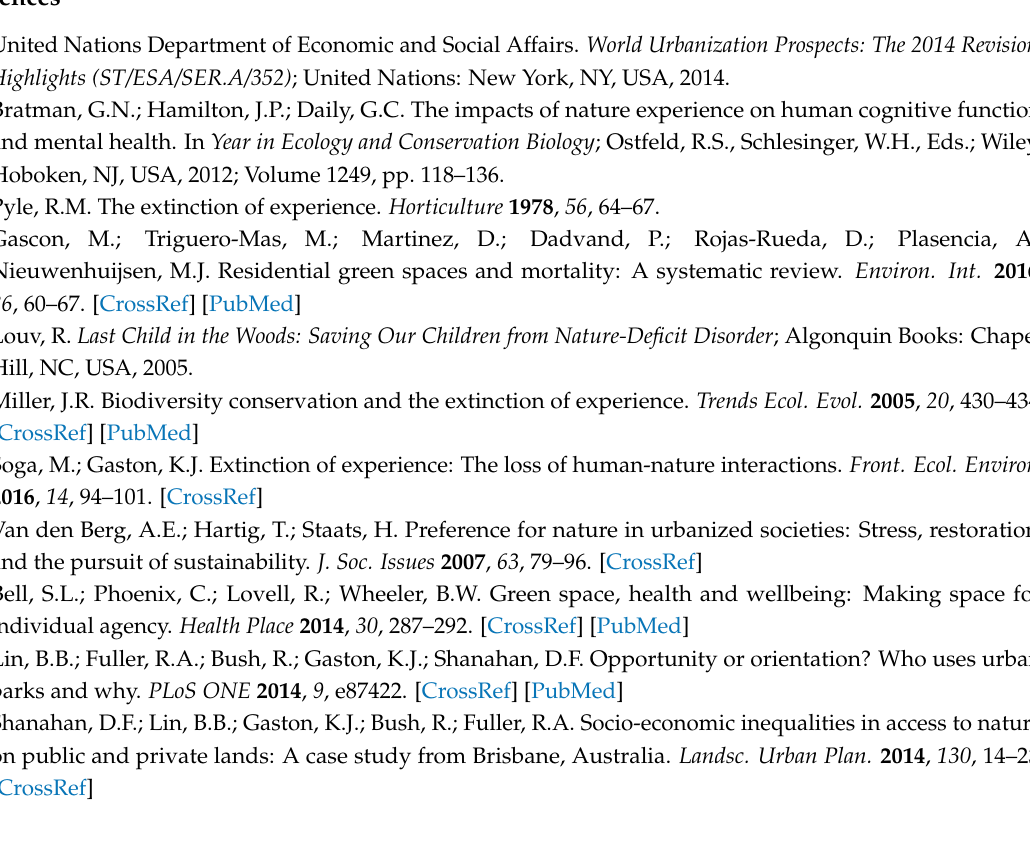
s1. Table S1: Socio-demographic variables, Table S2: Results from ordinal regression models (Cumulative link) assessing the relationship between socio-demographic predictor variables and nature relatedness score and nature relatedness self (Zero Order Correlations), Table S3: Results from ordinal regression models (Cumulative link) assessing the relationship between socio-demographic predictor variables and nature relatedness perspective and nature relatedness experience (Zero Order Correlations), Table S4: Results from ordinal regression models (Cumulative link) assessing the relationship between socio-demographic predictor variables and symptoms of depression, Table S5: Results from ordinal regression models (Cumulative link) assessing the relationship between socio-demographic variables and symptoms of anxiety, Table S6: Results from ordinal regression models (Cumulative link) assessing the relationship between socio-demographic predictor variables and symptoms of stress, Table S7: Results from ordinal regression models (Cumulative link) assessing the relationship between socio-demographic predictor variables and respondent’s assessment of their own health, Table S8: Results from ordinal regression models (Cumulative link) assessing the relationship between predictor variables and respondent’s assessment of their own health. These models consider each predictor separately without other variables (i.e., zero order correlations). The three predictors shown are important predictors of the health variables measured